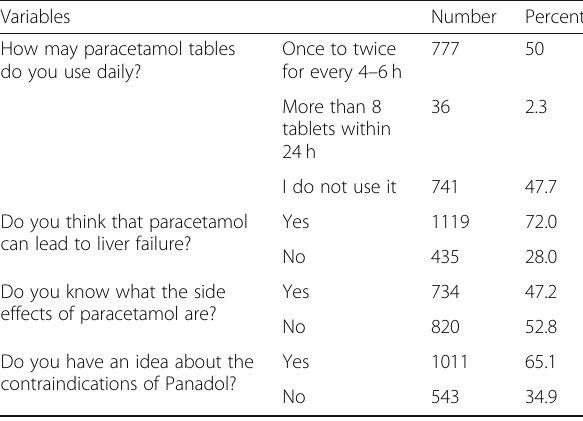
Table 3 Knowledge and awareness of participant about paracetamol or acetaminophen ( n = 1554) Variables